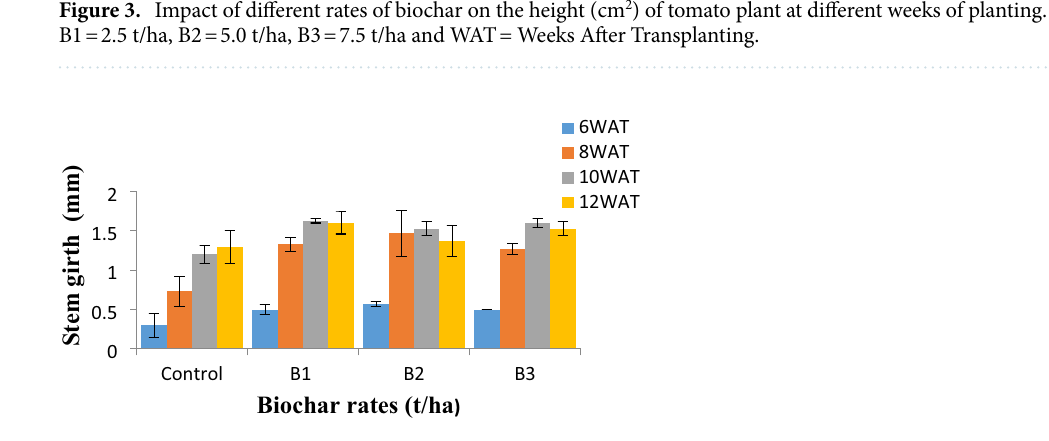
Figure 4. Impact of different rates of biochar on tomato stem girth (mm) at different weeks of planting, B1 = 2.5 t/ha, B2 = 5.0 t/ha, B3 = 7.5 t/h and WAT = Weeks After Transplanting.